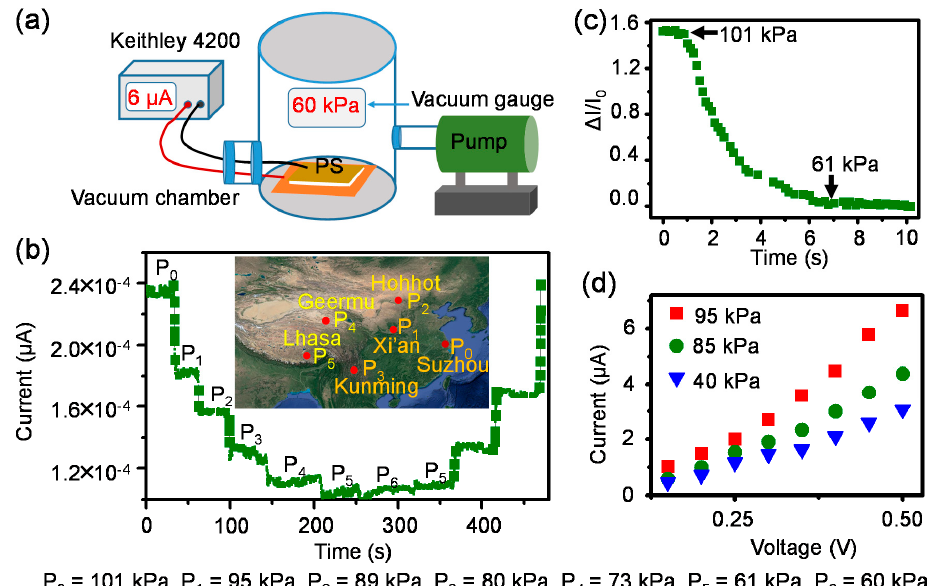
Figure 8. Air pressure detection. ( a ) The schematic illustration of air pressure control and signal record system. The response of device packed under atmosphere for the air pressure changes; ( b ) real-time output current under different air pressure levels; ( c ) Current response under the vacuum level continuously changed from 101 kPa to 60 kPa; ( d ) current-voltage curves under extremely high pressures.